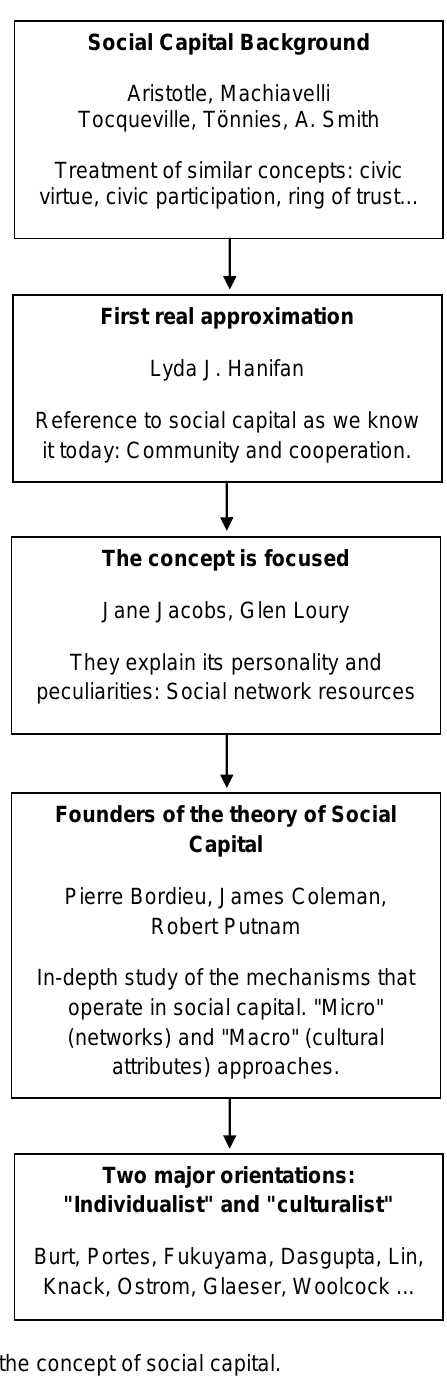
Figure 1 . Historical evolution of the concept of social capital. Castiglione, Van Deth and Wolleb (2008, p. 2) indicate that in the economic literature of